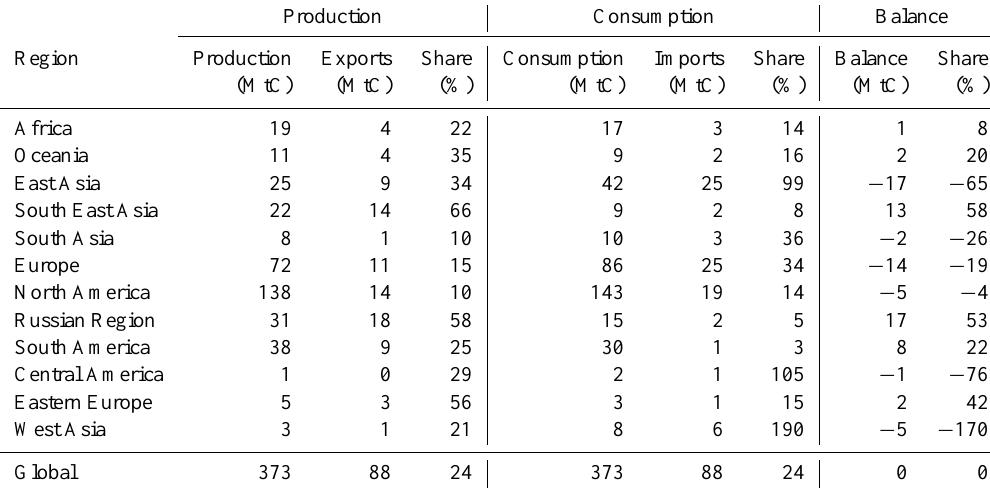
Table 10. The 2004 industrial roundwood extracted in each region (production) in terms of carbon, the amount and share exported, the consumption amount and share imported, and the difference between production and consumption (and exports and imports). Exports and imports only represent the trade between the RECCAP regions, and do not include the trade between countries within a region (e.g. Finland and Sweden). The shares are always in terms of